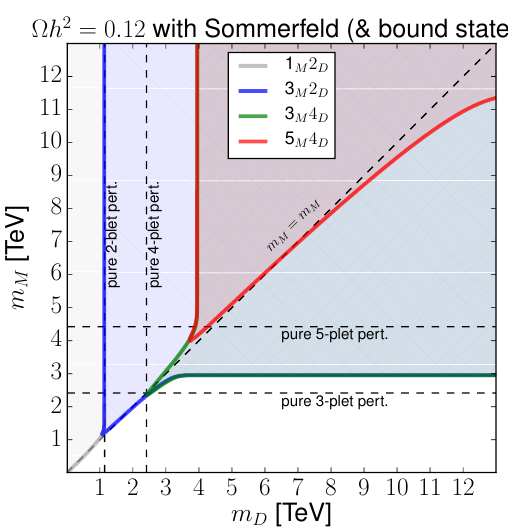
Figure 10. Boundaries of the DM candidate parameter space of HMDM models in the m M m D plane represented with continuous lines when computing the relic abundance in the SU(2) L symmetric limit with Sommerfeld corrections for the 2-blet, 3-plet, 4-plet limiting cases. For the 5-plet, BSF corrections of [22] are taken into account. As a guide for the eye, the perturbative results for the pure MDM cases are indicated with dashed